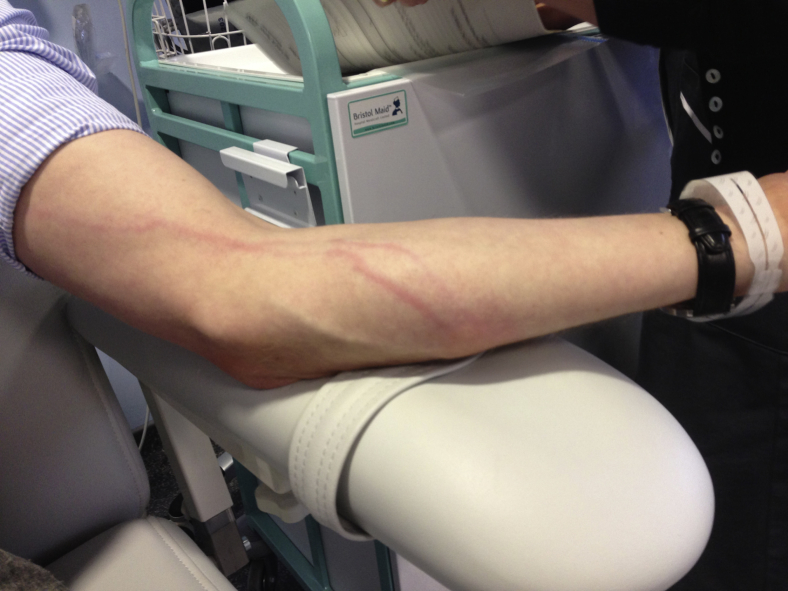
Lymphangitis in a participant who received active intradermal immunotherapy. The photograph was taken 40 minutes after intradermal injection.